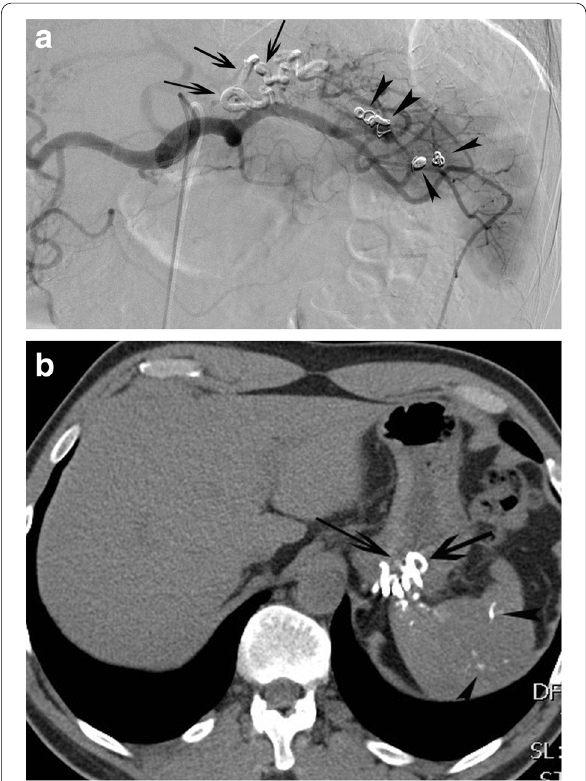
Fig. 2 a Selective splenic artery angiography after glue‑embolization shows the cast of the glue, completely occluding the cluster of hypertrophied arterial collaterals in the posterior gastric wall. b Follow‑up unenhanced CT reveals the dense cast of glue in the cluster of hypertrophied arterial collaterals (black arrows). Note also some droplets of glue (arrowheads), migrated into splenic